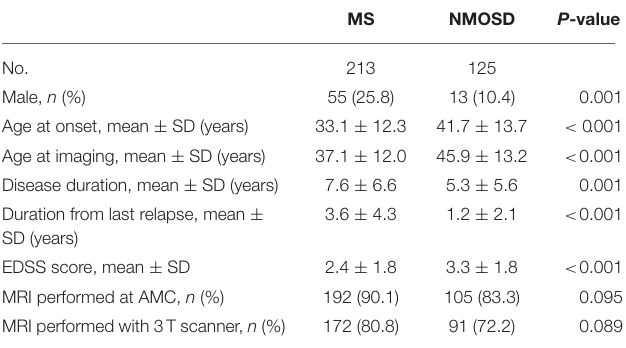
TABLE 1 | Baseline characteristics.